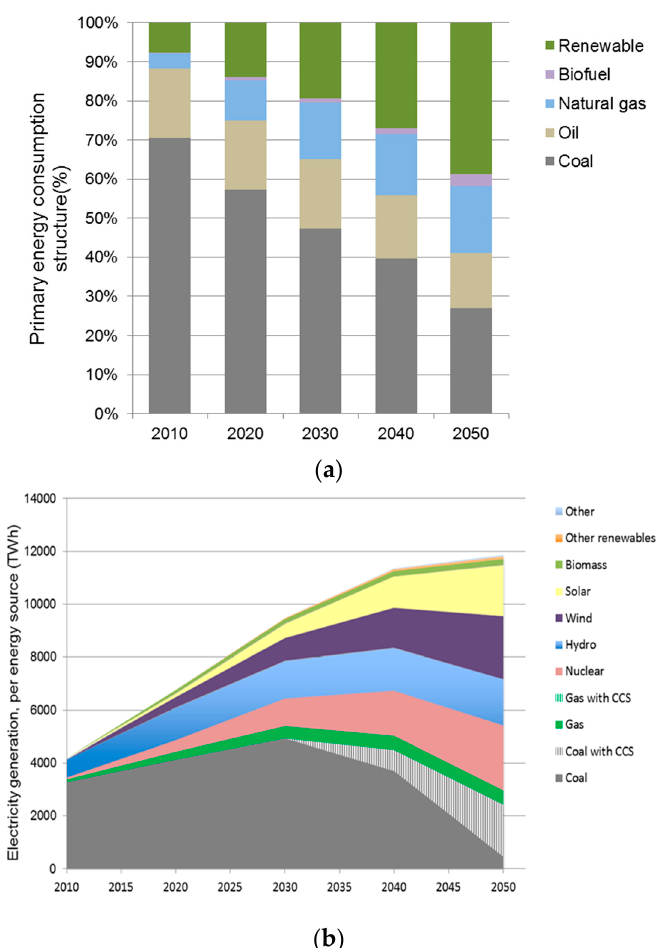
Figure 5. ( a ) Primary energy consumption structure, 2010–2050; and ( b ) electricity production by energy type, 2010–2050. CCS: carbon capture and storage.